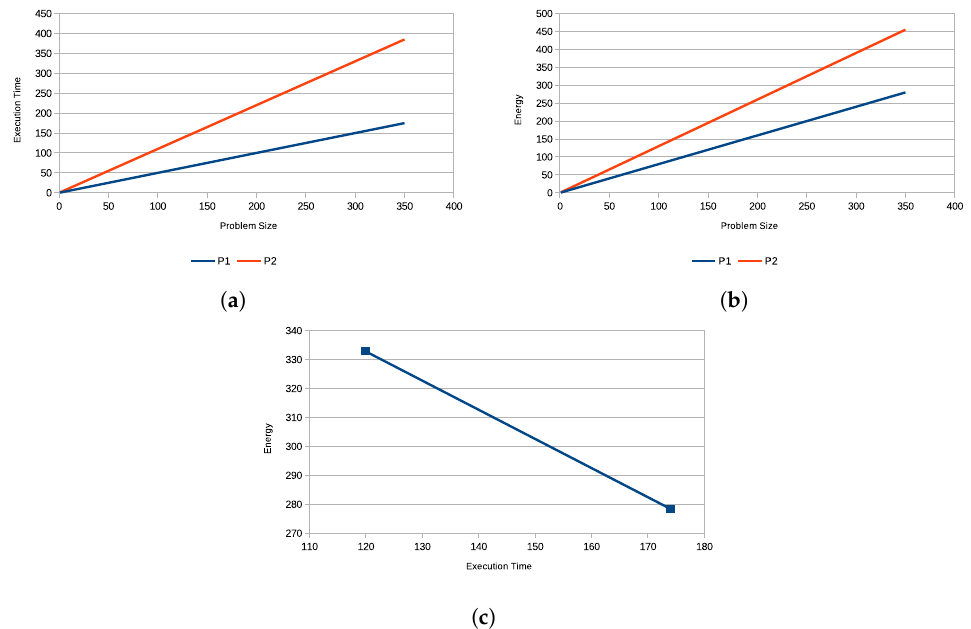
Figure 3. Solving bi-objective optimization problems for two processors with linear execution time and energy functions results in a linear Pareto front. The endpoints of the front are the solutions for single-objective optimization for performance and energy. ( a ). Linear execution time functions of workload size of the processors P 1 and P 2 . The units for workload size on the x-axis are Giga floating point operations. ( b ). Linear energy functions of workload size of the processors P 1 and P 2 . The units for workload size on the x-axis are Giga floating point operations. ( c ). Pareto-optimal solutions for a workload size